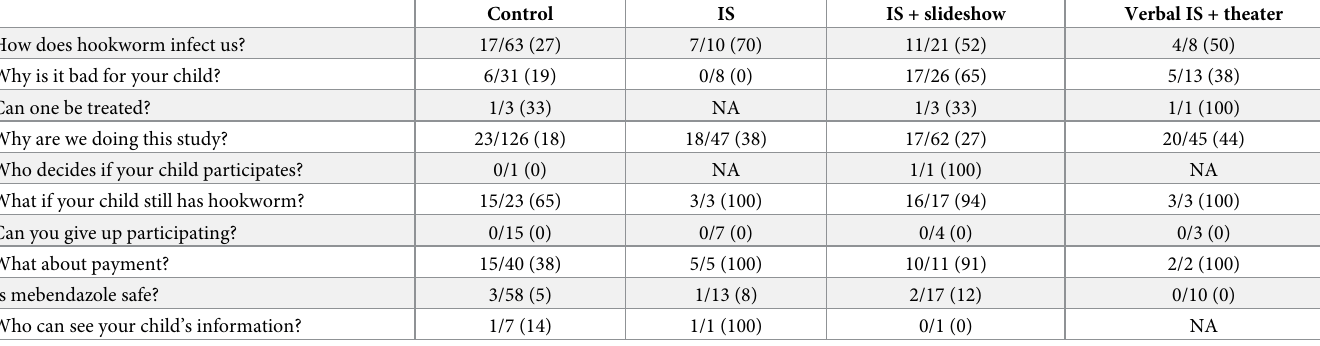
Table 3. Caregivers choosing the right answer to the ten main questions when probed (Part A2). Data are n (%).